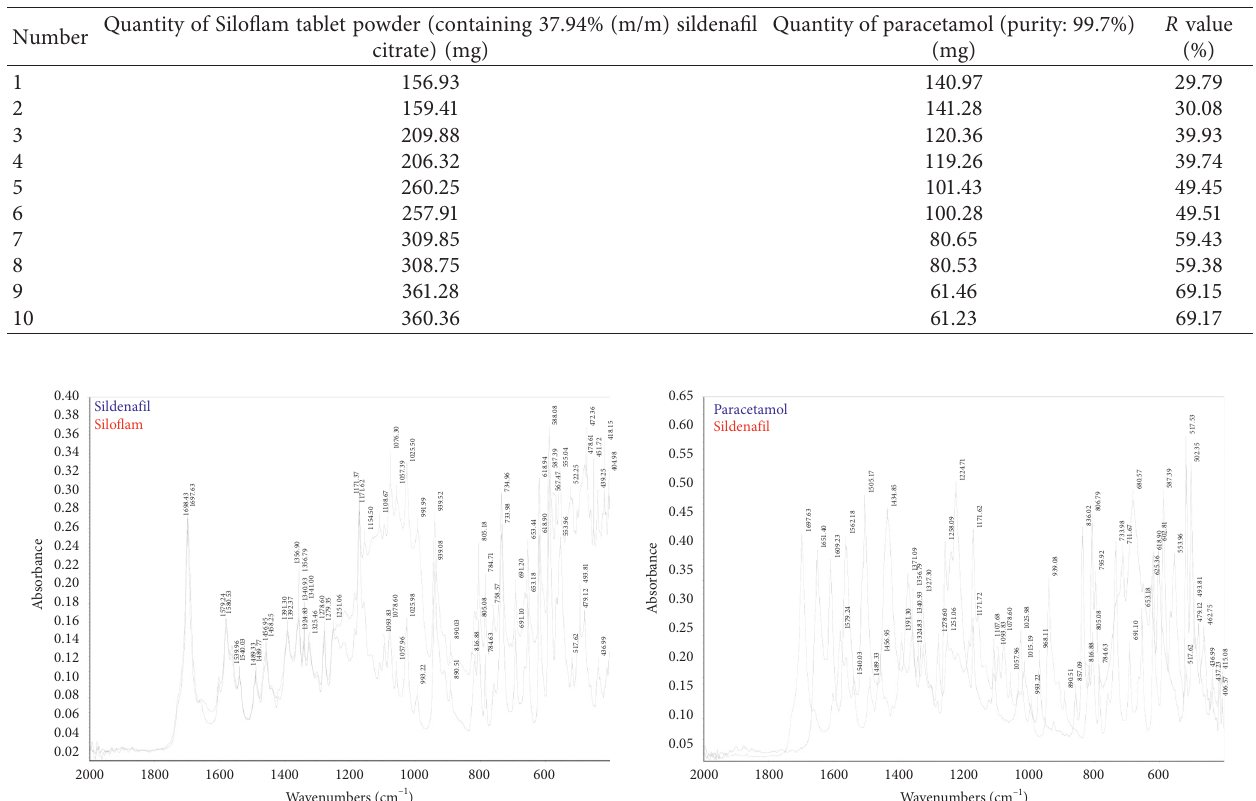
Table 1: Working standard mixtures for calibration model.